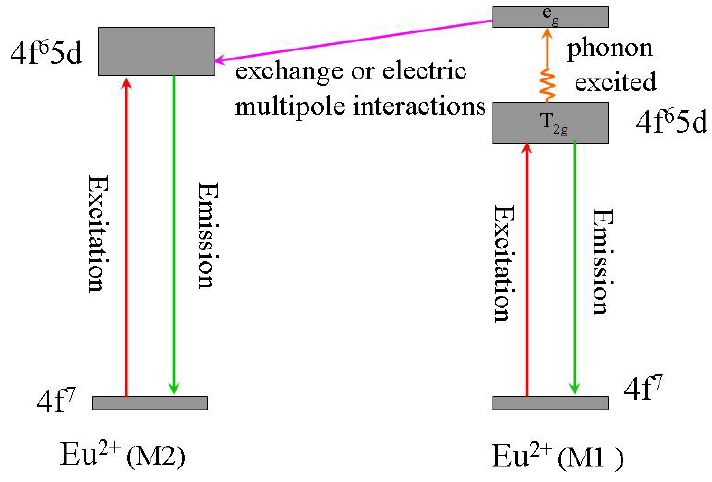
Figure 11. Schematic diagram of the thermal phonon-assisted tunneling of Eu 2+ from low-energy site to high-energy site.